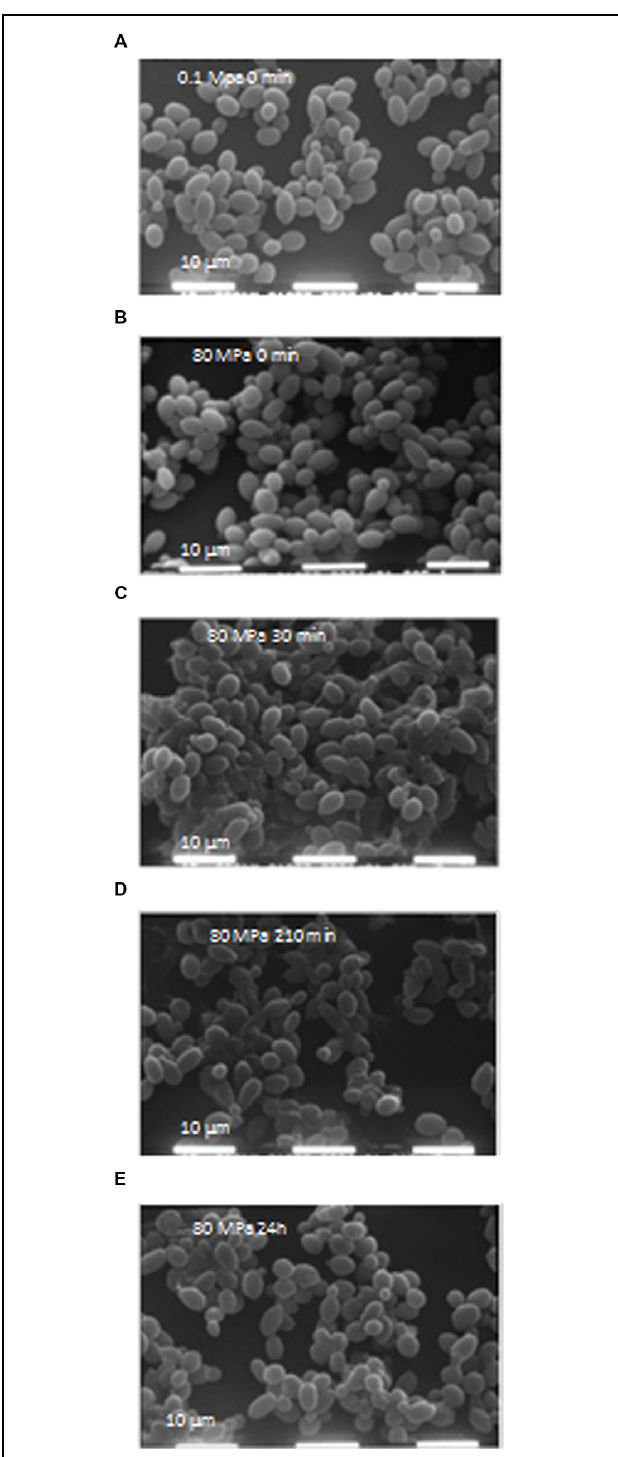
FIGURE 2 | (A–E) Scanning electron microscopy (SEM) images. Scale: 10 µ m; electron beam: 20 kV. (A) Cells at 0 min after 0.1 MPa high-pressure homogenization (HPH) treatment (control cells); (B) Cells at 0 min after 80 MPa HPH treatment; (C) Cells at 30 min after 80 MPa HPH treatment; (D) Cells at 210 min after 80 MPa HPH treatment; (E) Cells at 24 h after 80 MPa HPH